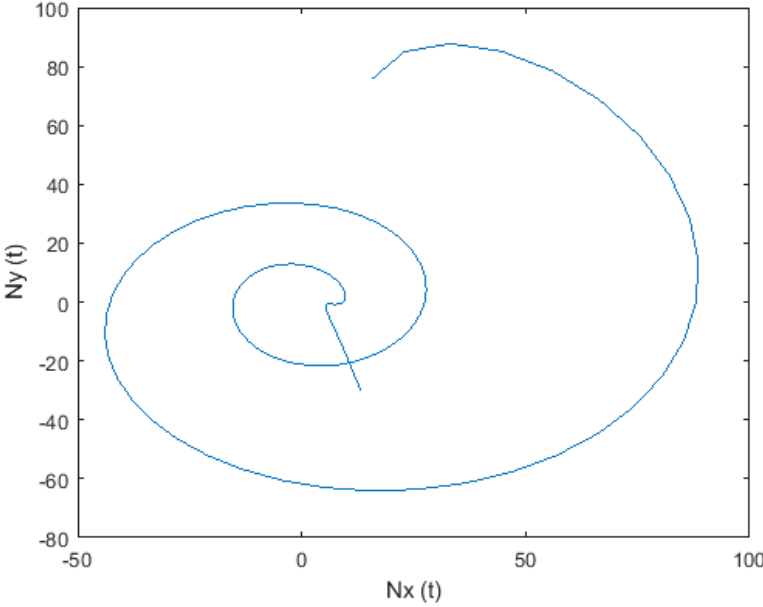
(cid:16) (cid:17) N x vs. N y with parameters: